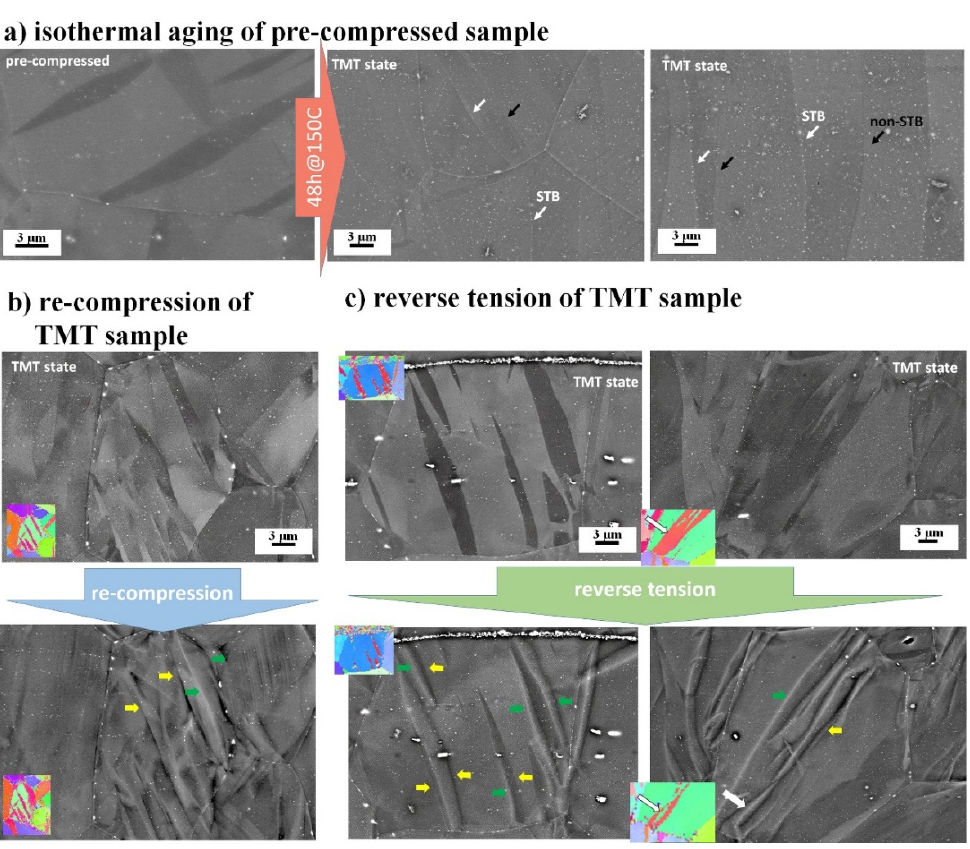
Figure 4. BSE images of the ZN10 alloy: ( a ) with respect to the isothermal aging to achieve TMT state (pre-compression up to 120 MPa and subsequent isothermal aging at 150 °C for 48 h); followed by ( b ) re-compression up to 3% of strain or ( c ) reverse tension up to 2% of strain. STB–segregated twin boundaries. ED is horizontal. Colored arrows highlight: yellow–immobile TB; green–mobile TB; white-newly nucleated twins, accordingly.